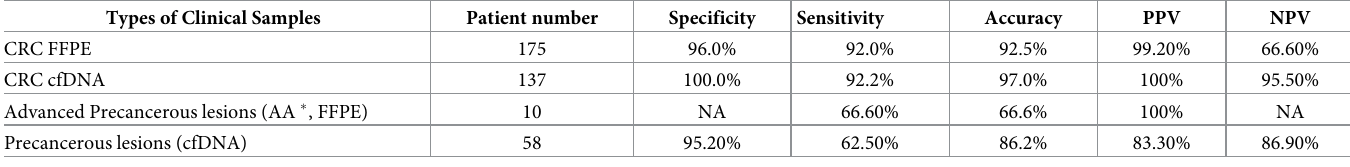
Table 6. Clinical sensitivity and specificity for FFPE and cfDNA samples.